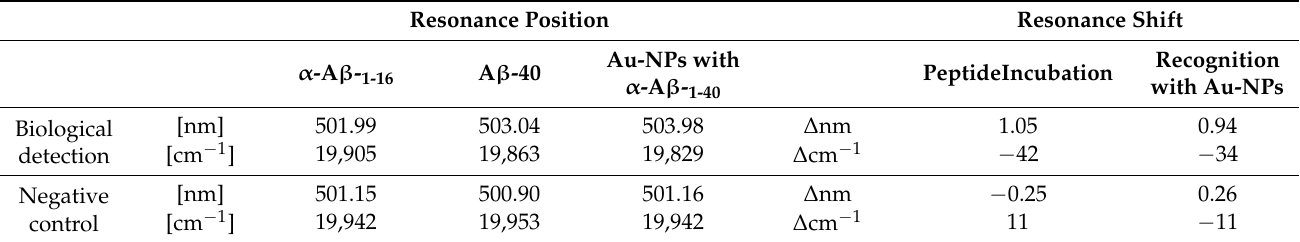
Table 2. Mean values of resonance positions (nm and cm − 1 ) and resonance shifts ( ∆ nm and ∆ cm − 1 ) of R-NPs arrays considered in the experiment, for both biological detection and negative control tests. Resonance Position Resonance Shift Recognition Au-NPs with α -A β - 1-16 A β -40 PeptideIncubation α -A β - 1-40 with Au-NPs